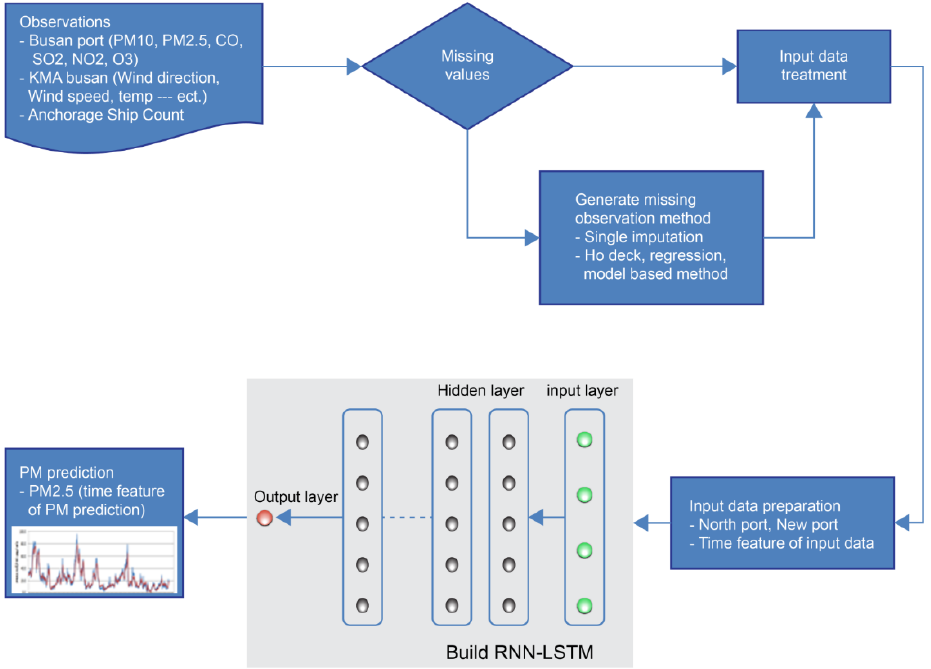
Figure 1. Workflow for predicting the concentration of PM 2.5 using the recurrent neural network and long short-term memory (RNN-LSTM) model.